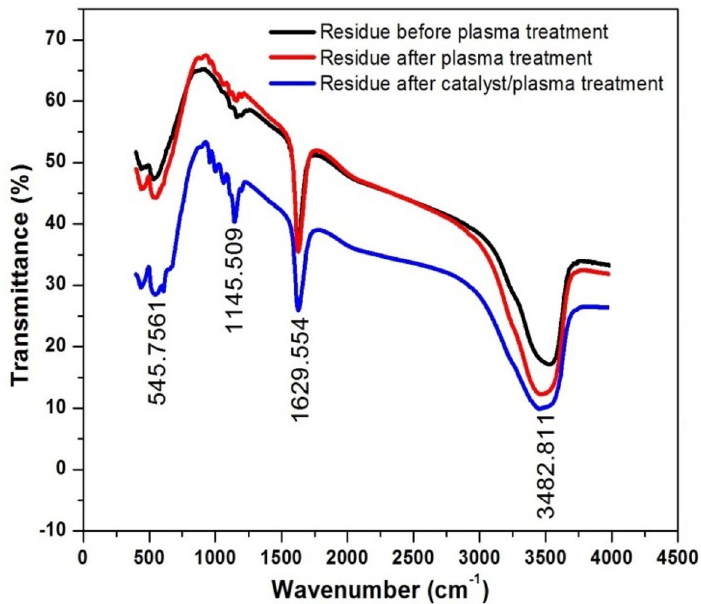
Figure 12. FTIR profiles of solid residues of untreated and treated wastewater.